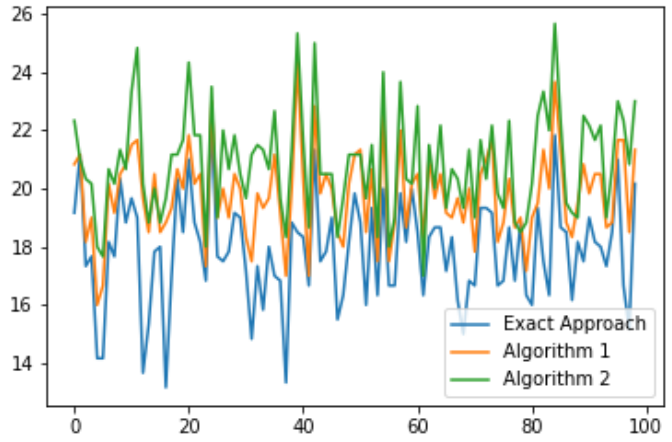
Figure 6. Graph of the dependence of the gap hours on the examples with a small variation of the duration.